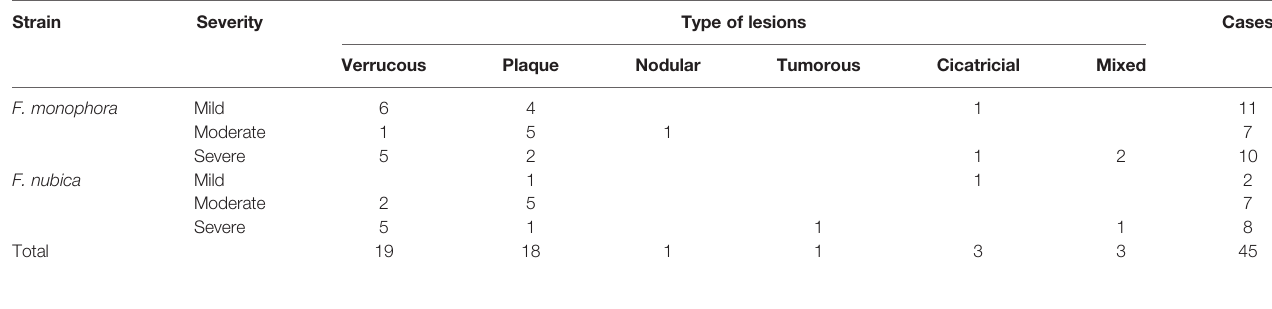
TABLE 2 | Clinical manifestation and species distribution of 45 CBM